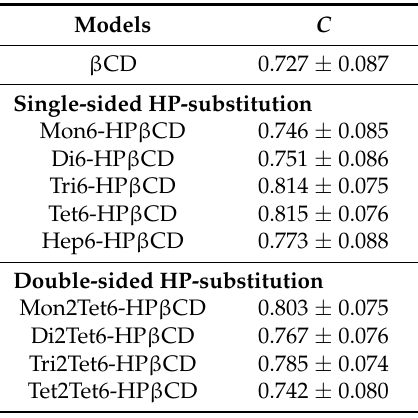
Table 3. The average and standard deviation of the circularity ( C ) of β CD and HP β CDs at 300 K, using REMD